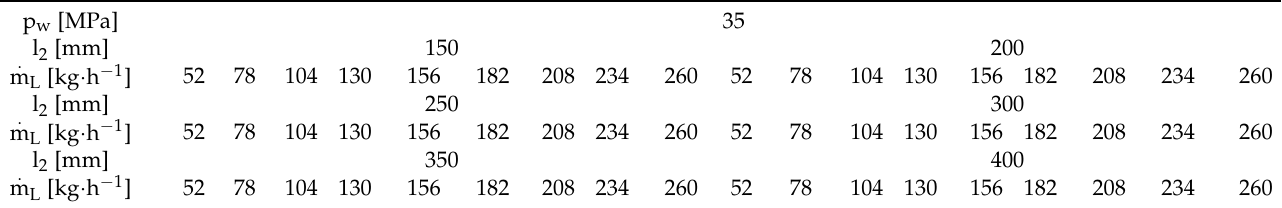
Table 3. Sample test variants for p w = 35 MPa, κ = 90 ◦